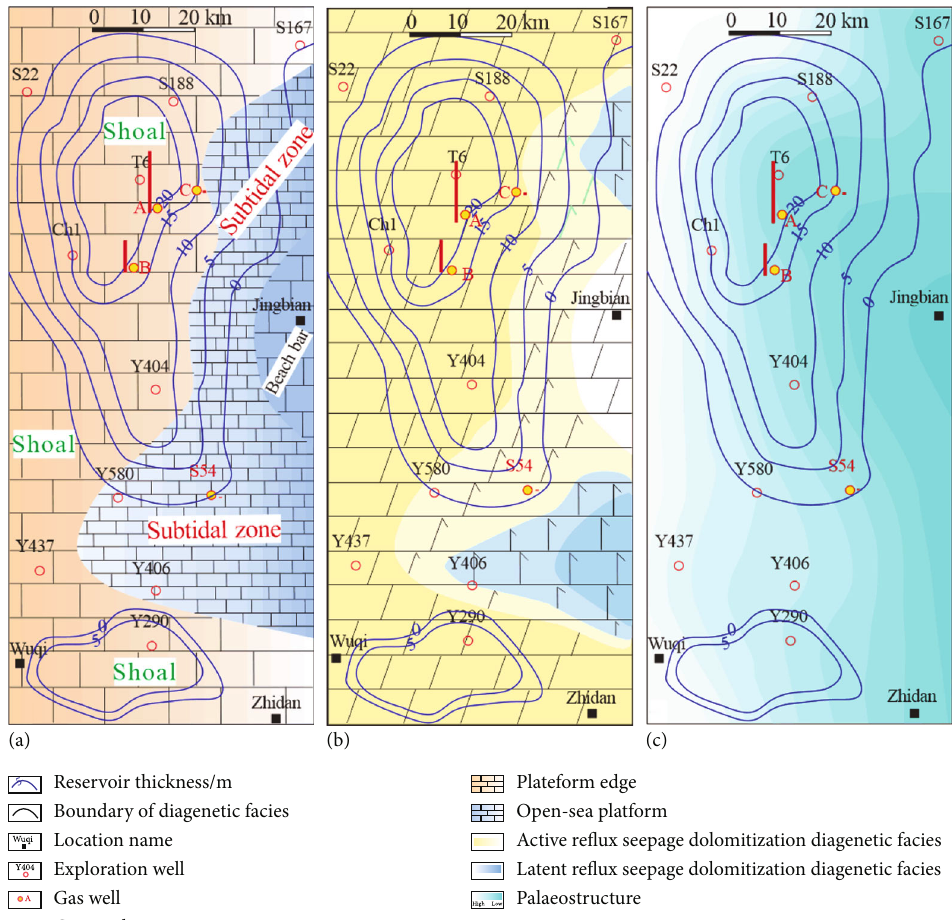
Figure 9: Relationship between di ff erent controlling factors and distribution of reservoir. ((a) Relationship between lithofacies palaeography and distribution of reservoir; (b) relationship between diagenetic facies and distribution of reservoir; (c) relationship between palaeostructure (top of the submember Ma5 ) and distribution of 5